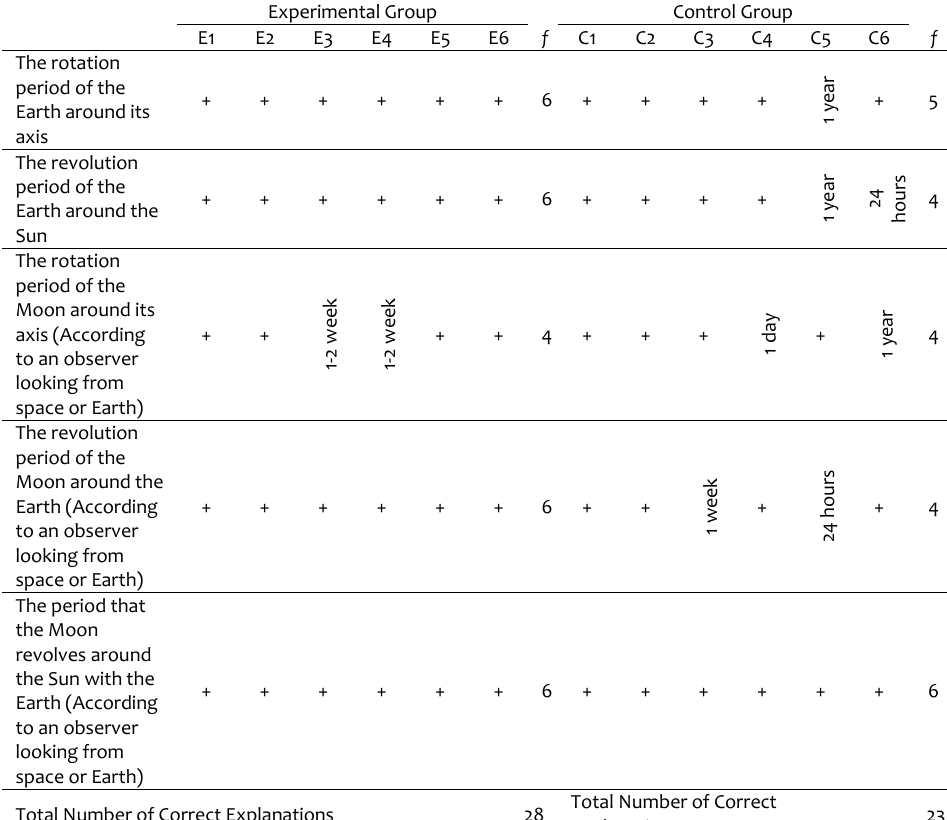
Table 5. Views of the experimental and control group students regarding the rotation and revolution periods of the Sun, Earth and